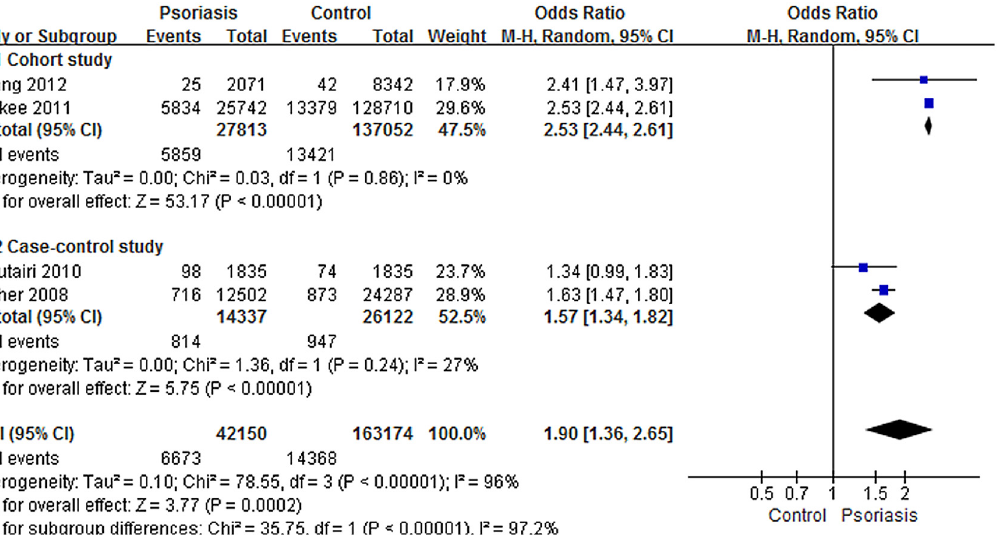
Fig 2. Meta-analysis of the prevalence of chronic obstructive pulmonary disease (COPD) in patients with psoriasis compared with controls. “ Events ” means the number of COPD in subjects. Odds ratios (ORs) for COPD in subjects with psoriasis compared with subjects without psoriasis. The point estimate (center of each blue square) and the statistical size (proportional area of the square) are shown. Horizontal lines indicate 95% confidence intervals. The pooled OR (diamond) was calculated using a random effects